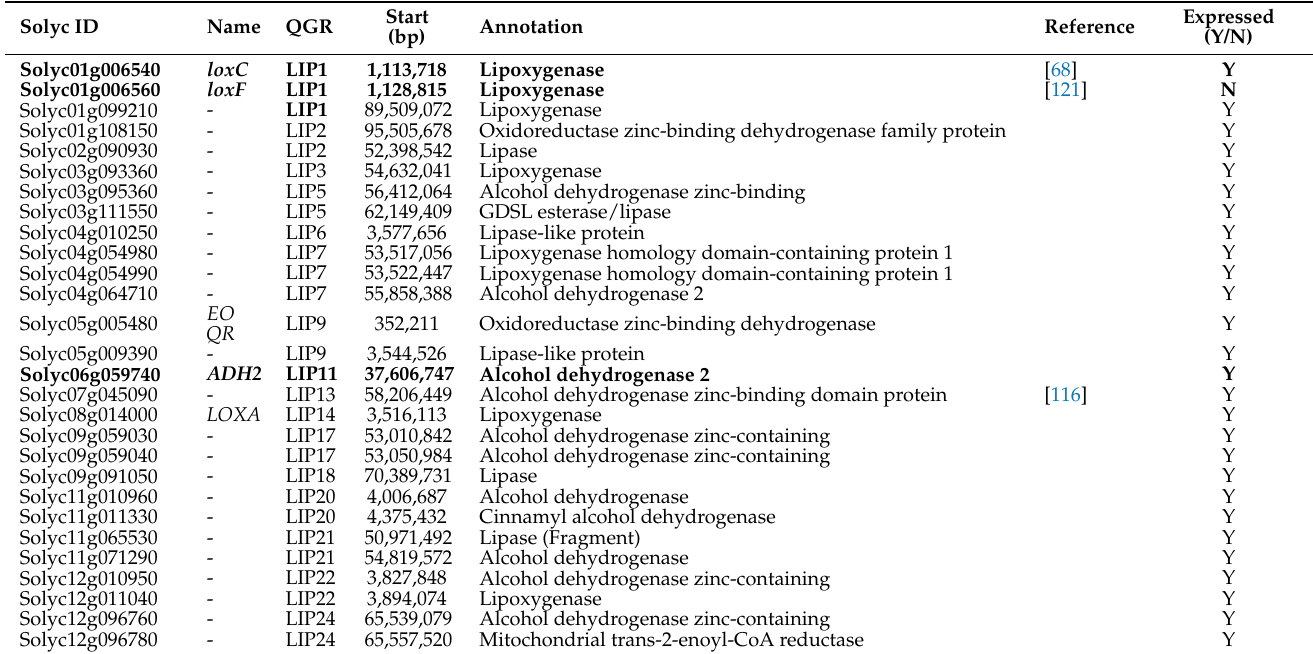
Table 3. List of the genes identified as potentially responsible for the lipid VOCs QTLs reported in literature. Genes that have been functionally characterized are highlighted in bold in the table. The last column reports whether the gene has been reported to be expressed in fruit (Y/N—[103]), for a complete overview of the gene expression see Table S1. Solyc